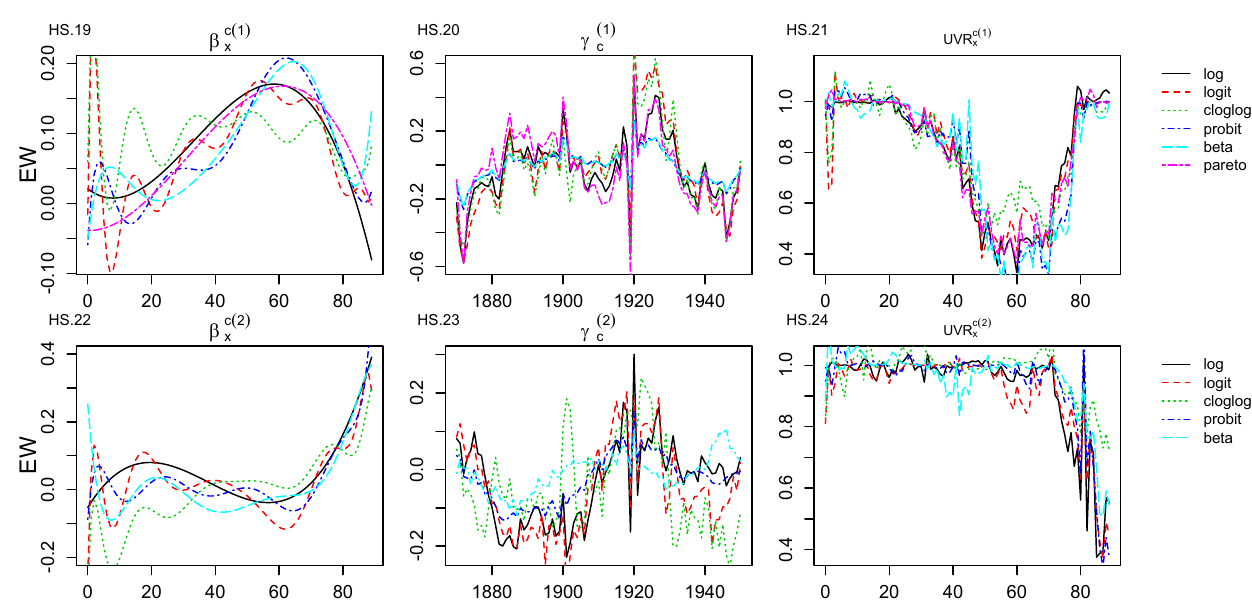
Figure A3. First and second age-cohort component for E&W